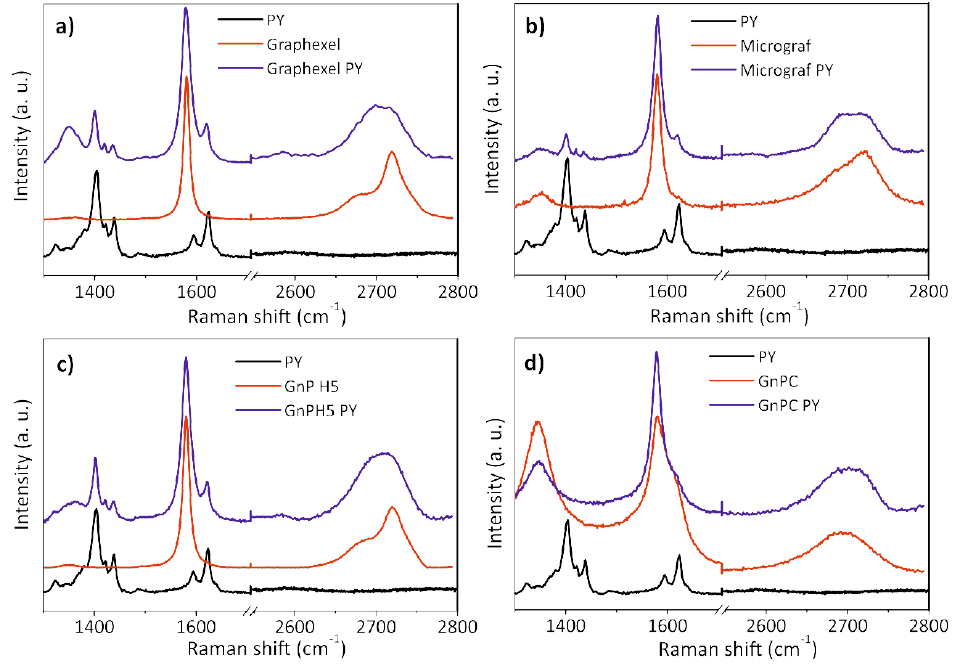
Figure 5. Raman spectra of the pyrene derivative, graphite starting material, and exfoliated graphite: ( a ) Graphexel; ( b ) Micrograf; ( c ) GnPH5; and ( d ) GnPC.